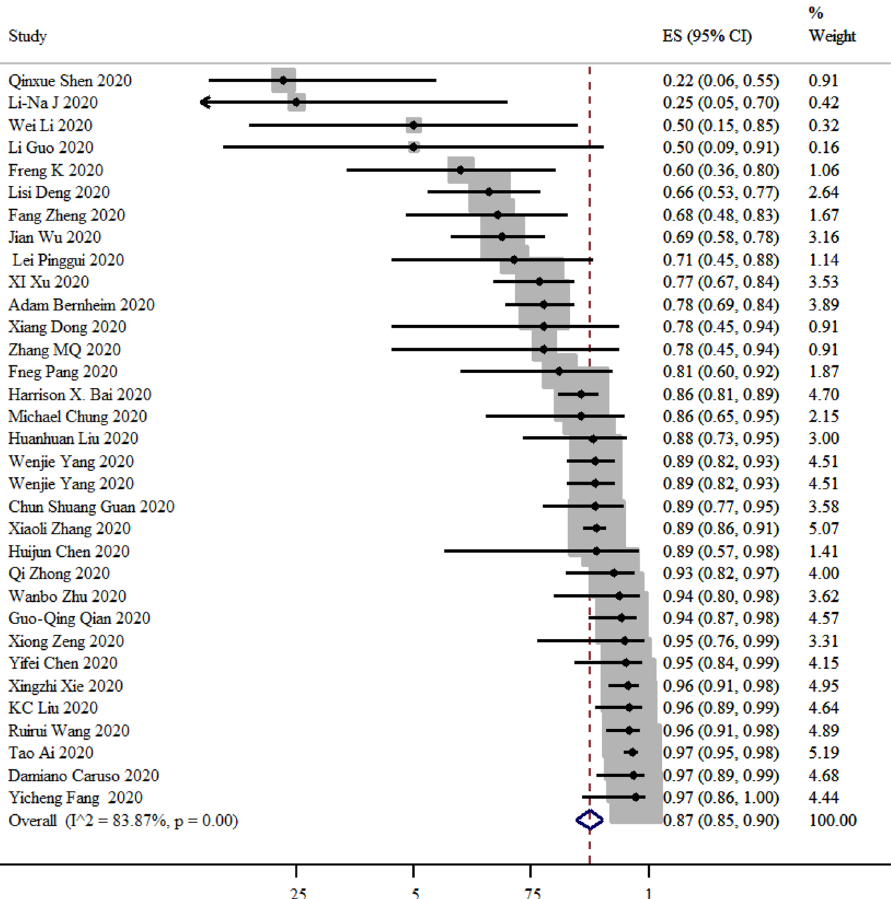
Figure 3. Summary of sensitivity and 95% CI, generated by the STATA.